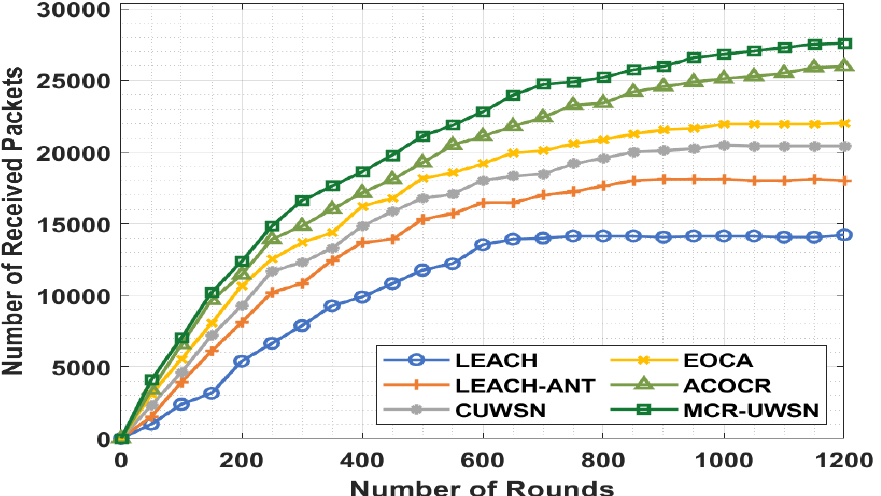
Figure 7. NRP analysis of MCR-UWSN method with existing approaches